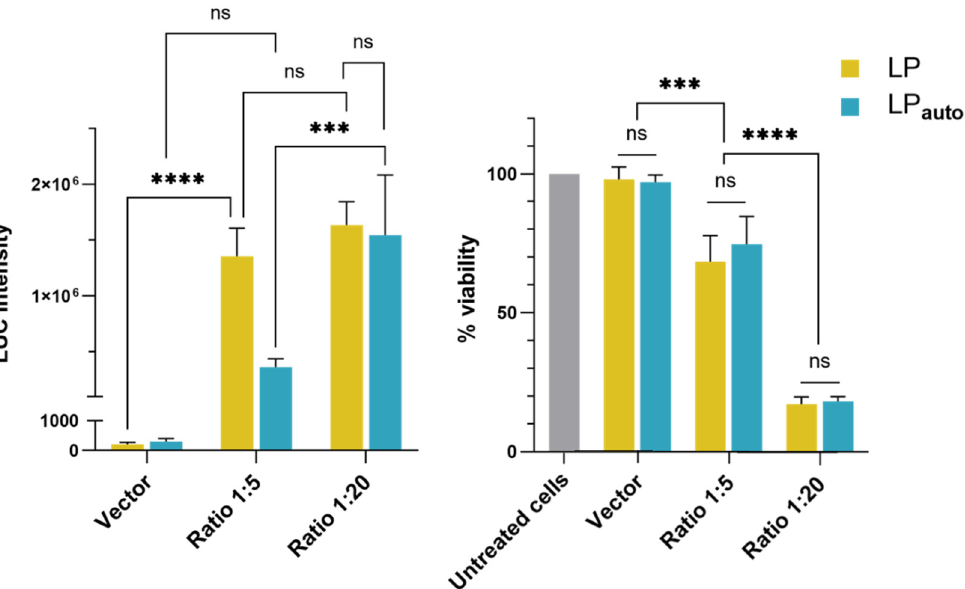
Figure 5. In vitro evaluation of ( left ) transfection efficiency using Bright-Glo luciferase assay and ( right ) cell viability (PrestoBlue assay) of pLbL formulations. Transfections were performed on DC2.4 cells. Measurements were always performed 24 h post transfection. Data are presented as the mean ± SD (not significant (ns): p > 0.05, ***: p < 0.001, ****: p < 0.0001).